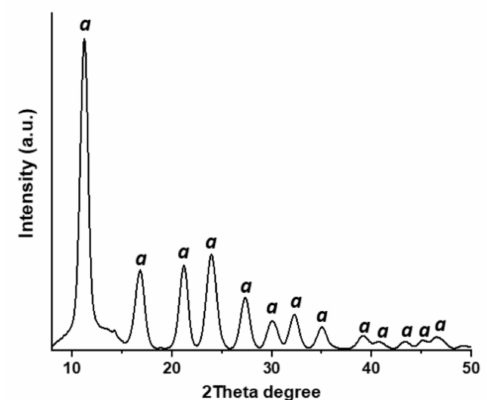
Figure A4. PXRD pattern of the hydrothermally synthesized titania. Peaks labeled “ a ” belongs to the anatase phase.